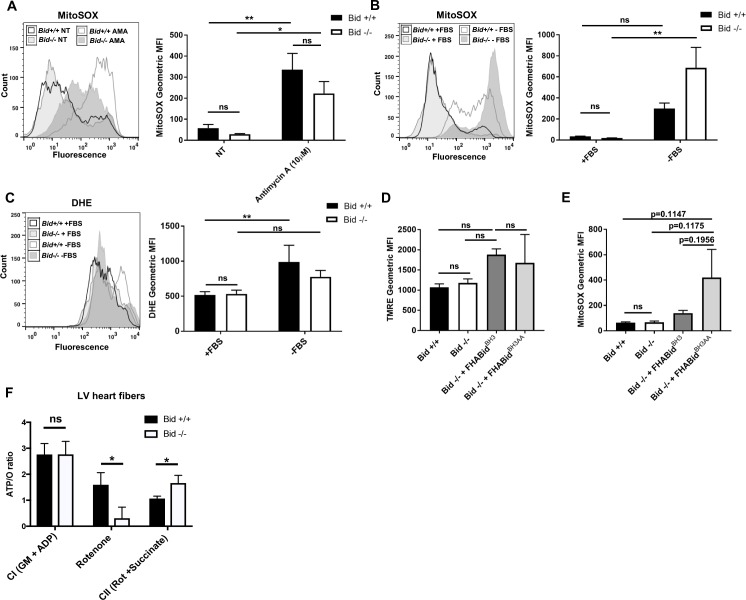
Bid-/- MPCs maintain their membrane potential and do not increased ROS.(A) Bid+/+ and Bid-/- MPCs were cultured for 24 hr in complete media (no treatment = NT) or treated with10 µM Antimycin A (AMA) as a positive control for the last two hours followed by staining with 2 µM MitoSOX for mitochondrial ROS. Data are represented as geometric mean fluorescence intensity (MFI) (NT n = 7,6 and AMA n = 6,6 for Bid+/+ and Bid-/-, respectively). (B) Bid +/+ and Bid-/- MPCs were subjected to serum withdrawal for 24 hr and stained with MitoSOX (n = 4,4 for Bid+/+ and Bid-/- with and without FBS). (C) Treatment as in (B) followed by staining with 5 µM of DHE for cellular ROS (n = 11,10 with FBS and n = 4,4 without FBS for Bid+/+ and Bid-/-, respectively). (D) Mitochondrial membrane potential assessed with 50 nM TMRE in Bid +/+, Bid-/-, Bid-/- + FHA-BidBH3 and Bid-/- + FHA-BidBH3AA MPCs (n = 4,4,4,3 respectively). Cells overexpressing BH3- or BH3AA-mutanted Bid were gated on CD25 high expressing cells (i.e. only cells containing FHA-Bid). (E) Mitochondrial ROS of the indicated cell lines measured with MitoSOX as in (D) (n = 4,4,4,3 respectively). (F) ATP/O ratio determined from data shown in Figure 6E and F. P-values were determined by two-way ANOVA (p<0.001) with Tukey’s post test for (A–C), one-way ANOVA (not significant) with Student’s t-test (two-tailed) (D), (E), and two-way ANOVA with unpaired Student’s t-test for (F). Error bars indicate ± SEM for all data. ns = not significant, *p<0.05, **p<0.01.